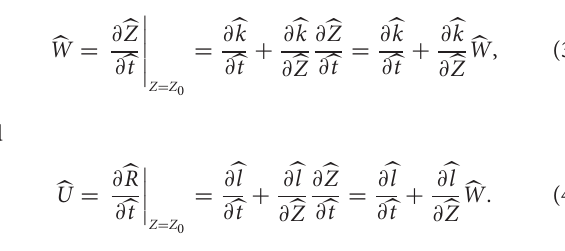
eccentricity of ellipse, ǫ is a dimensionless varying parameter and η is the wavelength of the metachronal wave. One assumes that the fluid and adjacent cilia tips have the same velocity resulting in a no-slip condition. Therefore, the axial and radial velocities can be written as